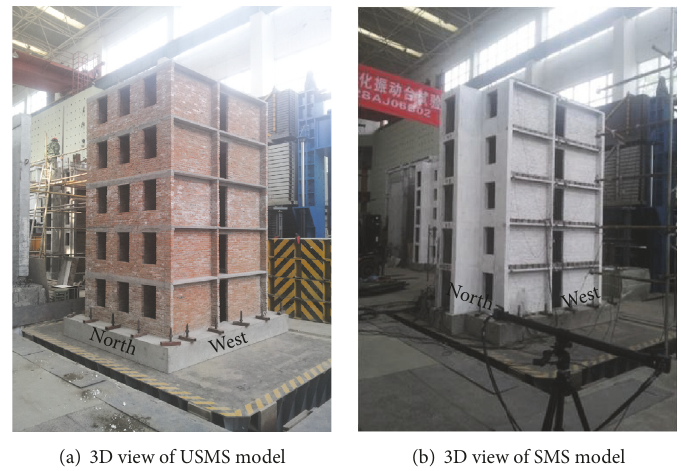
Figure 3: Connecting nodes of the strengthened model.